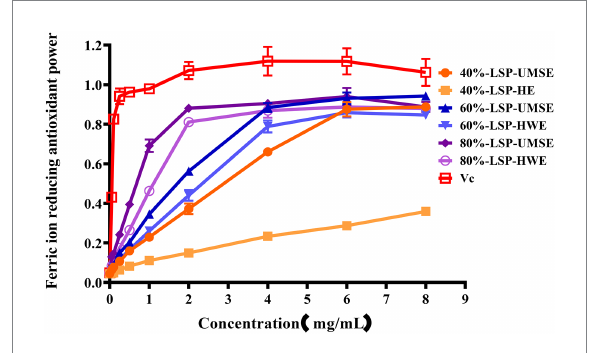
FIGURE 7 LSP-UMSE and LSP-HWE for ferric ion chelating activity. Each value is expressed as mean ± SEM ( n = 3).